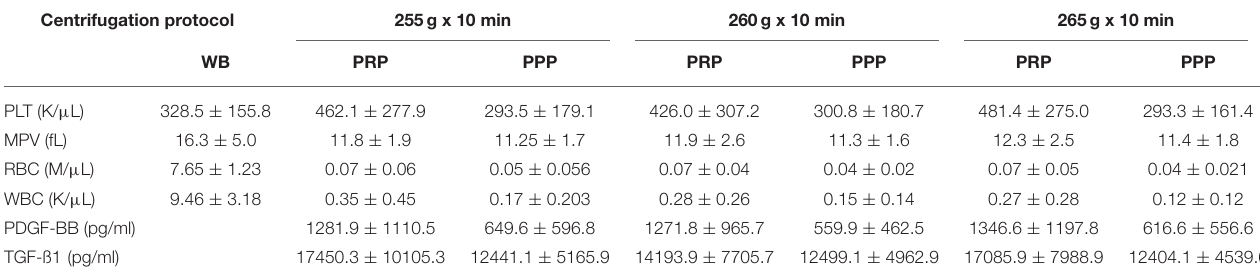
TABLE 1 | Mean ± SD of platelet (PLT) concentrations, mean platelet volume (MPV), erythrocytes (RBCs) and leukocytes (WBCs) concentrations in whole blood samples (WB) and in the PRP and PPP fractions; platelet-derived growth factor BB (PDGF-BB) and transforming growth factor β 1 (TGF- β 1) concentrations in the PRP and PPP fractions in 30 cats ( n =